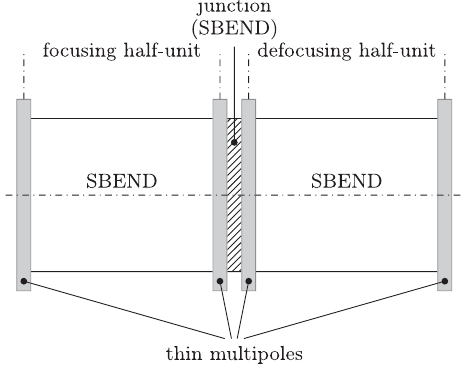
FIG. 18. Cross section of one MU of the PS. The reference point between the two poles corresponds to the location of the closed orbit. The circuits of the PFW, which are encapsulated by an epoxy resin, are situated directly on top of the poles. Furthermore, the main coils and the F8L are visible [33].